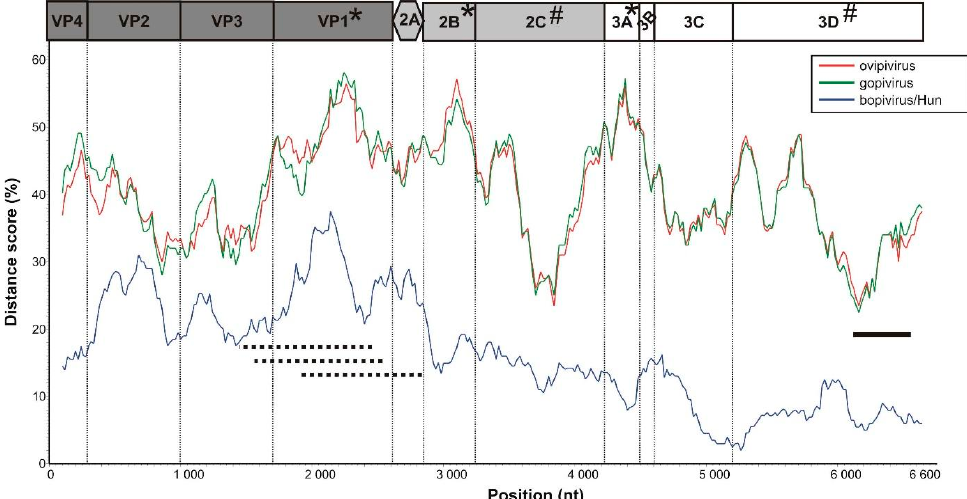
Figure 5. Distance plot of ovipi-, gopi-, and bopi-virus/Hun compared to the bopivirus A1 (KM589358) as a query sequence (reference) in a multiple nt alignment with a window size of 200 bp and a step size of 20 bp. Each line is a comparison between the CDS of ovipivirus (red), gopivirus (green) and bopivirus/Hun (blue) and the reference genome. Horizontal black line: the position of the RT-PCR product generated by the generic bopivirus screening oligonucleotide primers (HBG-3D-Screen-R/F). Horizontal dotted lines: positions of the RT-PCR products generated by the multiple primer sets used in various bopivirus typing RT-PCR reactions (Supplementary Table S2). Vertical dotted lines: borders of given genome regions indicated in the genome map above the plot. The most diverse (*) and most conserved (#) genome regions between ovipi-, gopi- and bopi-viruses are indicated in the bopivirus genome map.